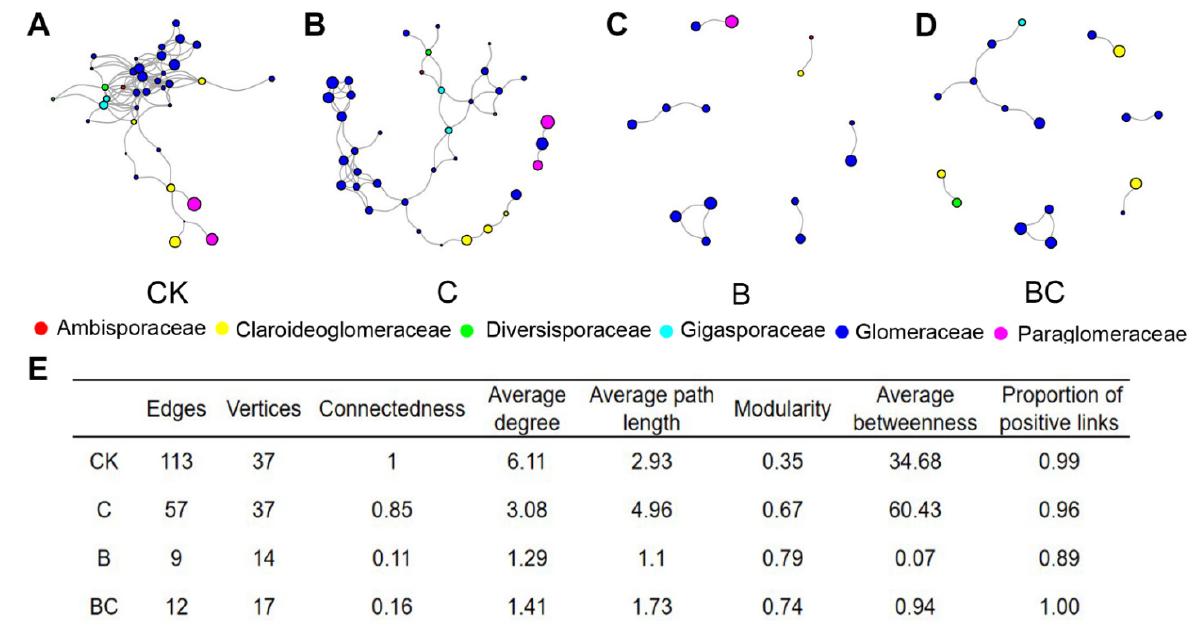
Figure 5. AM fungal co-occurrence networks in control ( A ), compost addition ( B ), biochar addition ( C ) and biochar with compost addition treatments ( D ); topological properties among AM fungal co-occurrence networks ( E ). In ( A – D ), the size of each node is proportional to its relative abundance, the color of each node represents family.